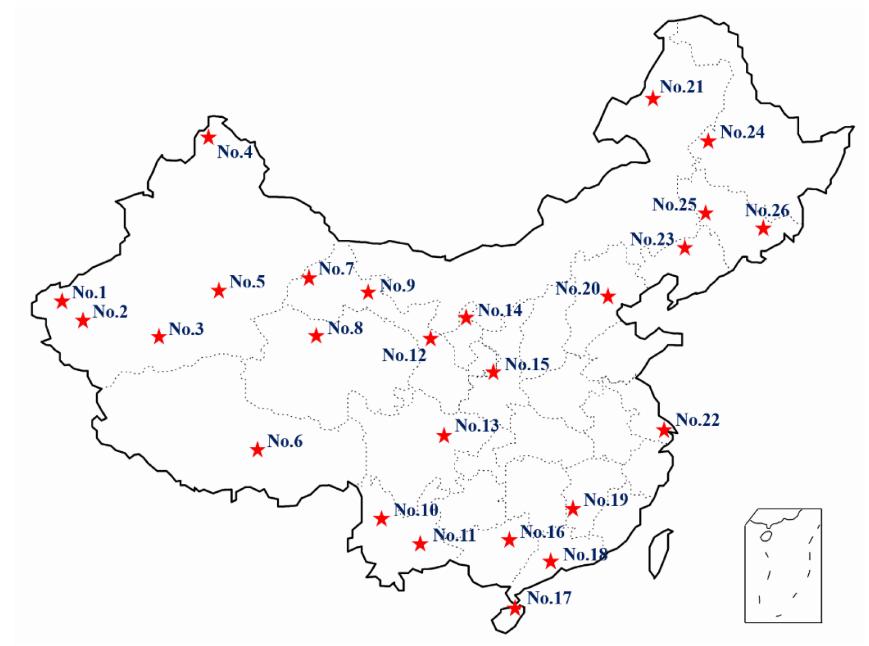
Figure 4. Geographic position of 26 regions in China.